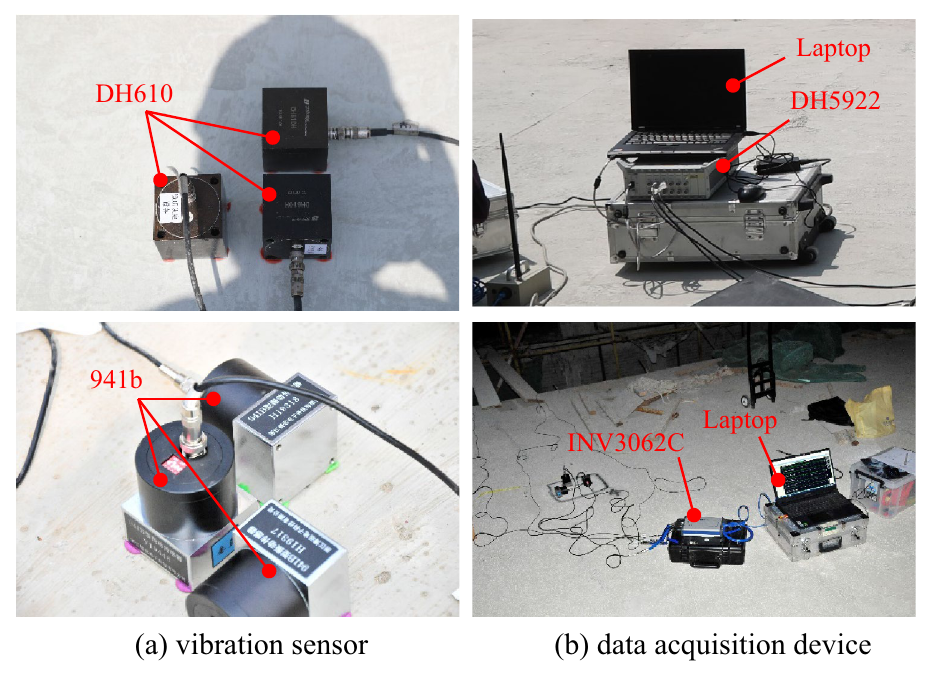
Figure 2. Vibrator sensor, data acquisition device.